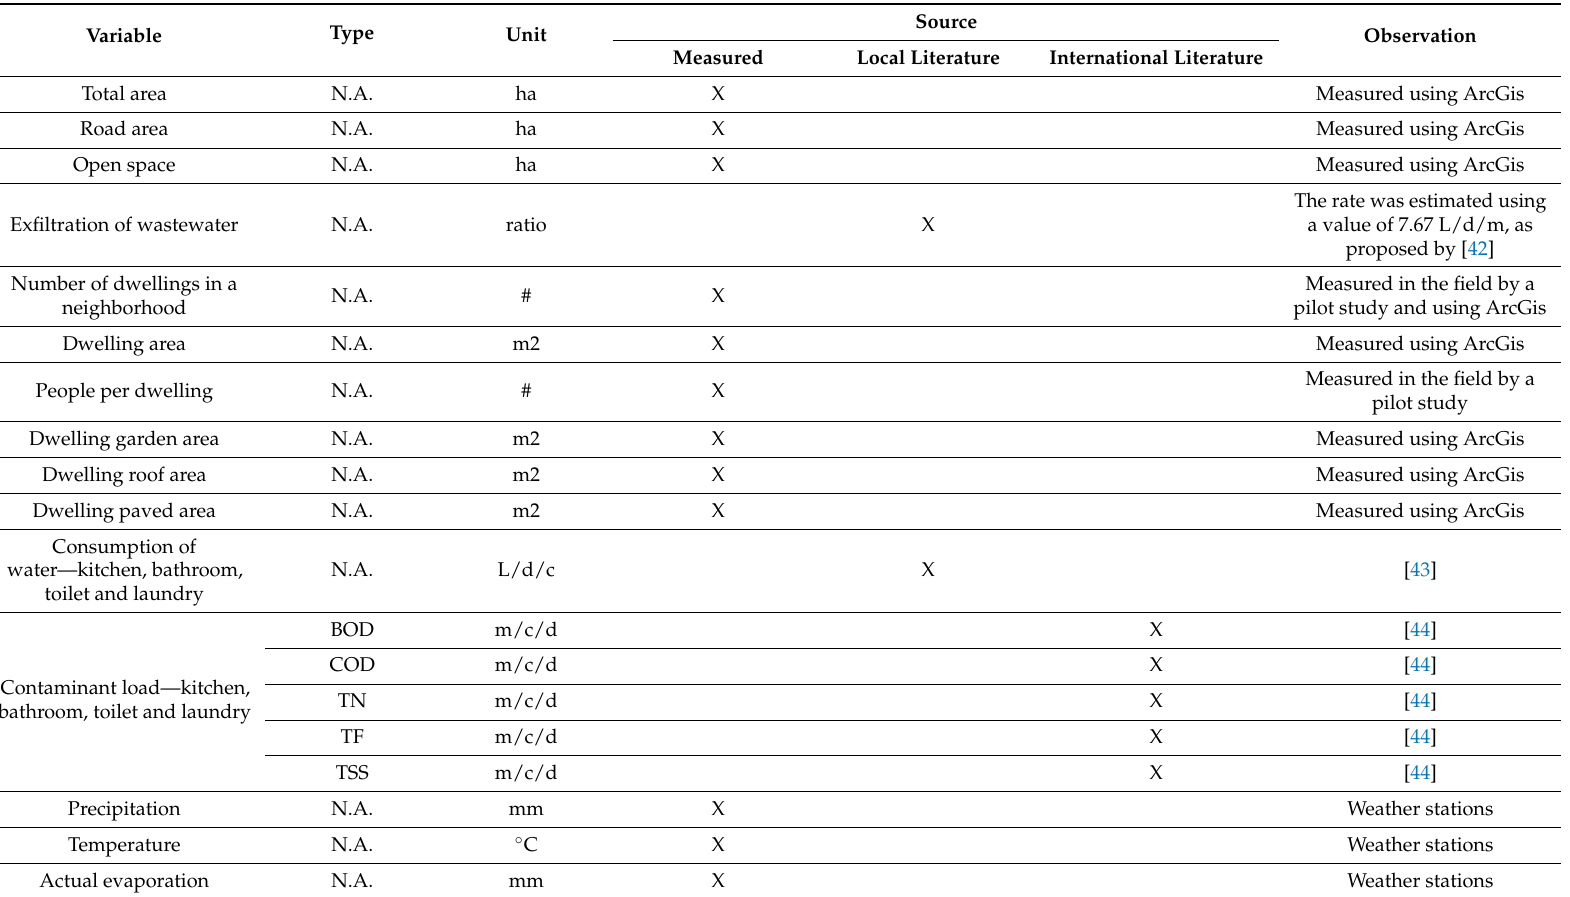
Table 1. Input variables and their